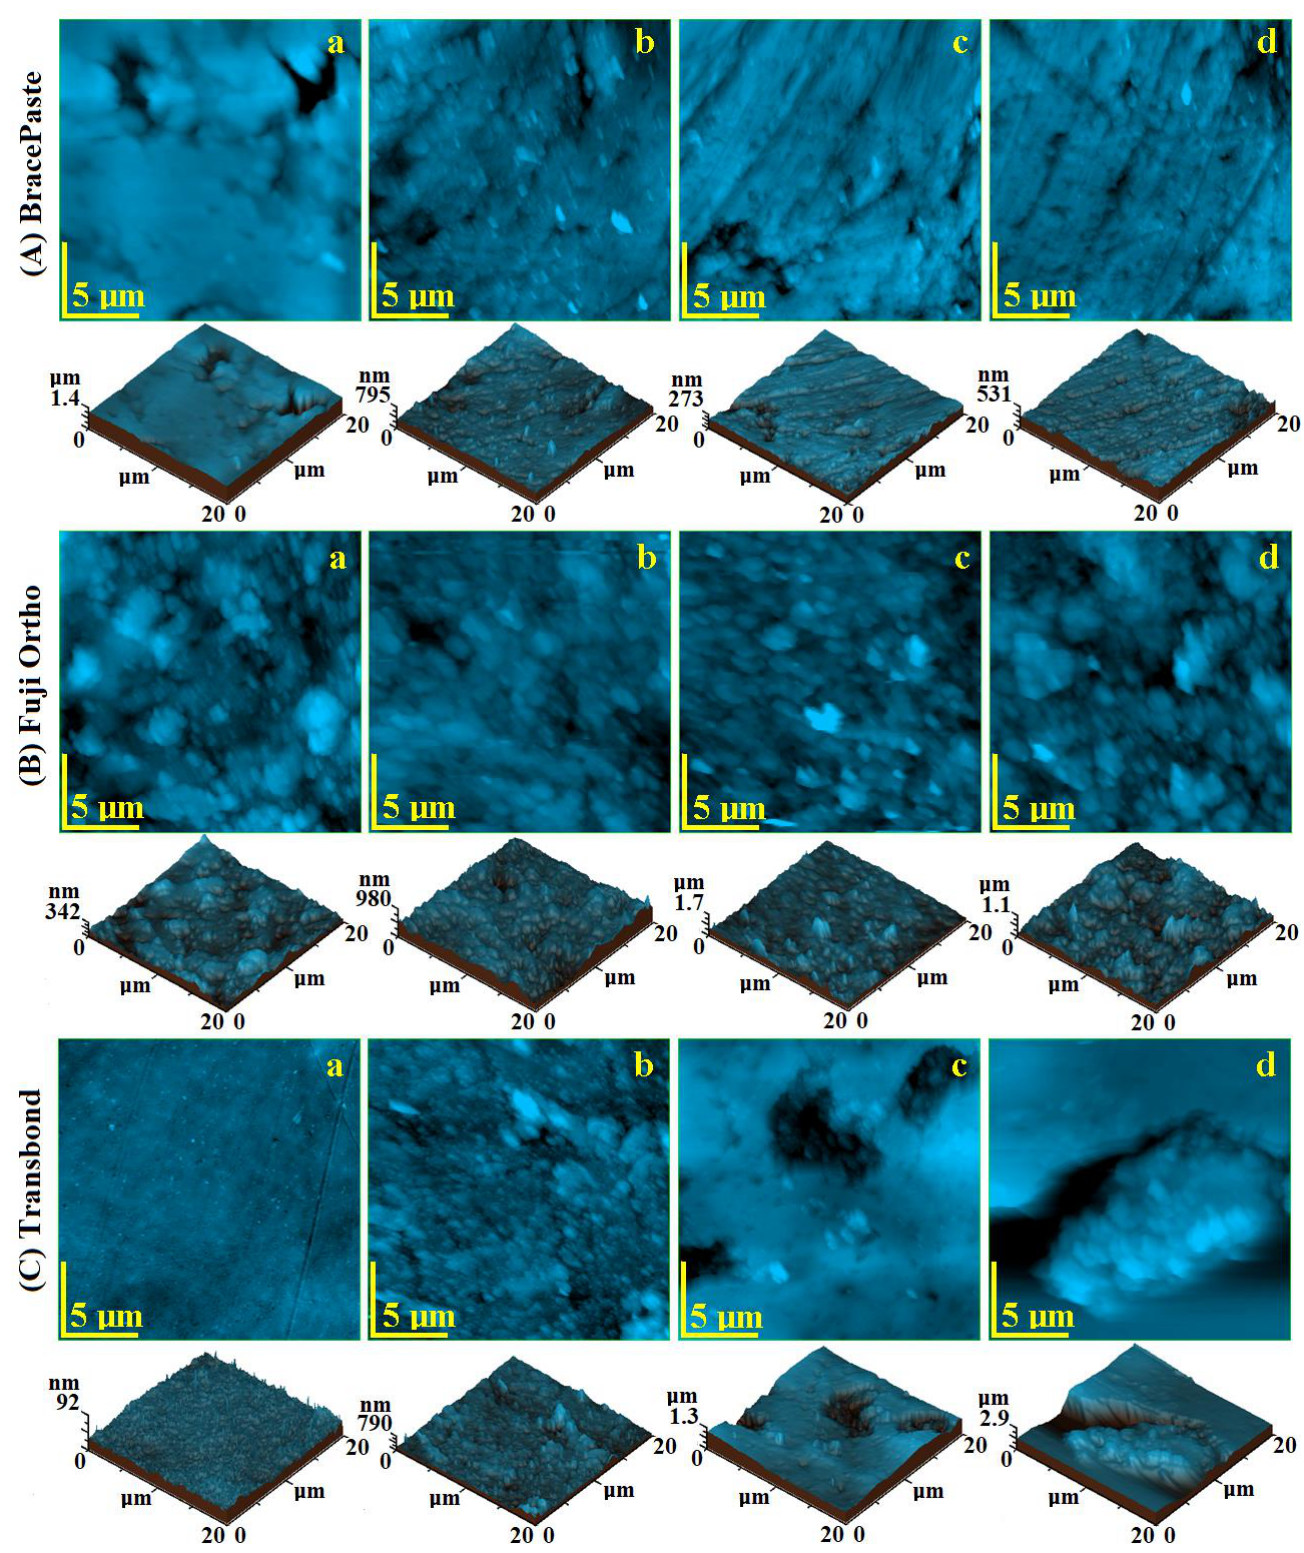
Figure 5. AFM images of the investigated samples: BracePaste ( A ); Fuji Ortho ( B ) and Transbond ( C ) exposed to different liquid environments: ( a ) initial — unexposed, ( b ) artificial saliva, ( c ) Coca-Cola and ( d ) Red Bull.